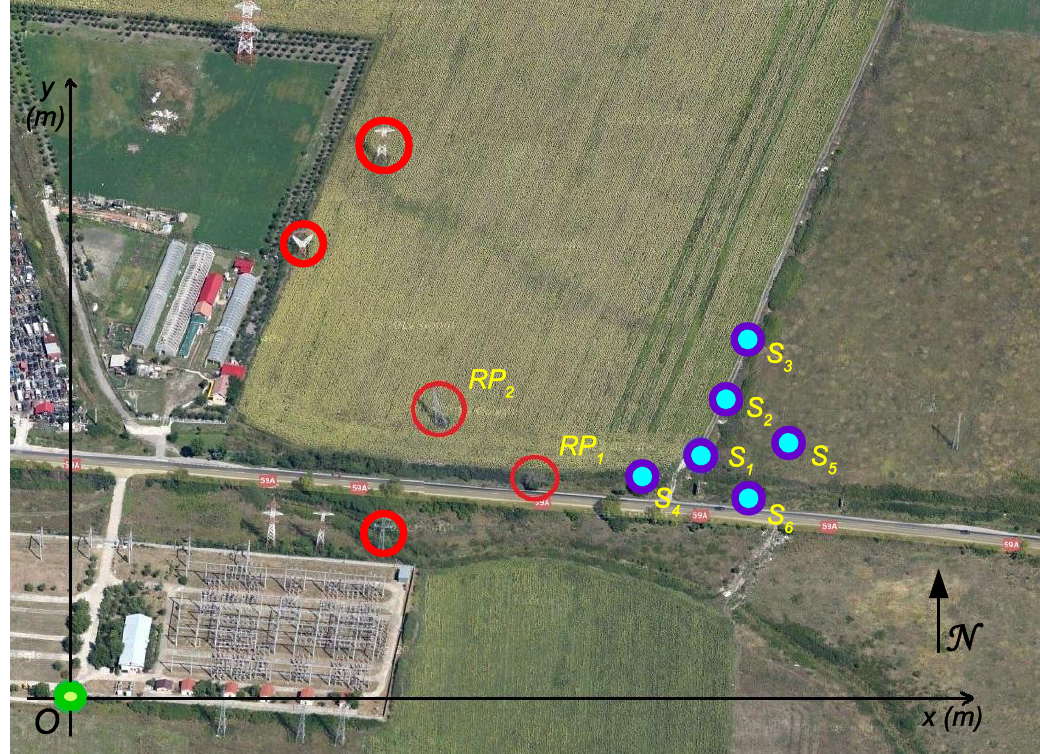
Figure 7. Network deployment area with highlighted reference objects on a Google